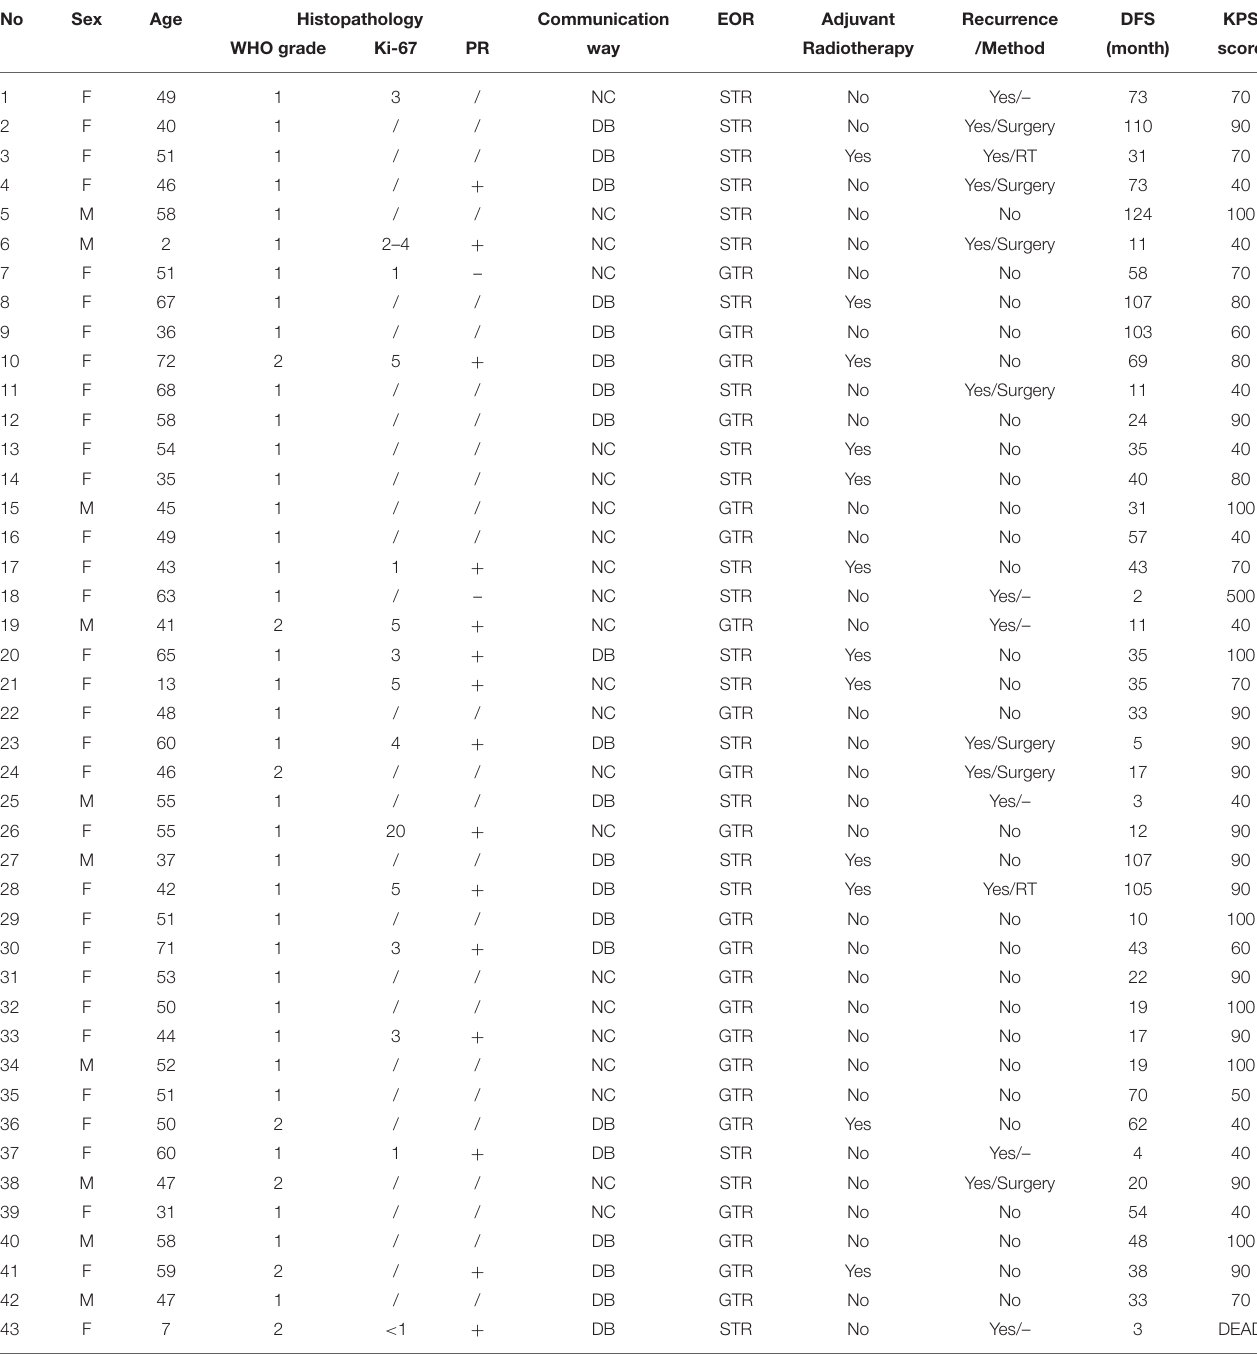
TABLE 4 | Follow-up data of the 43 of 53 patients with skull base communicative